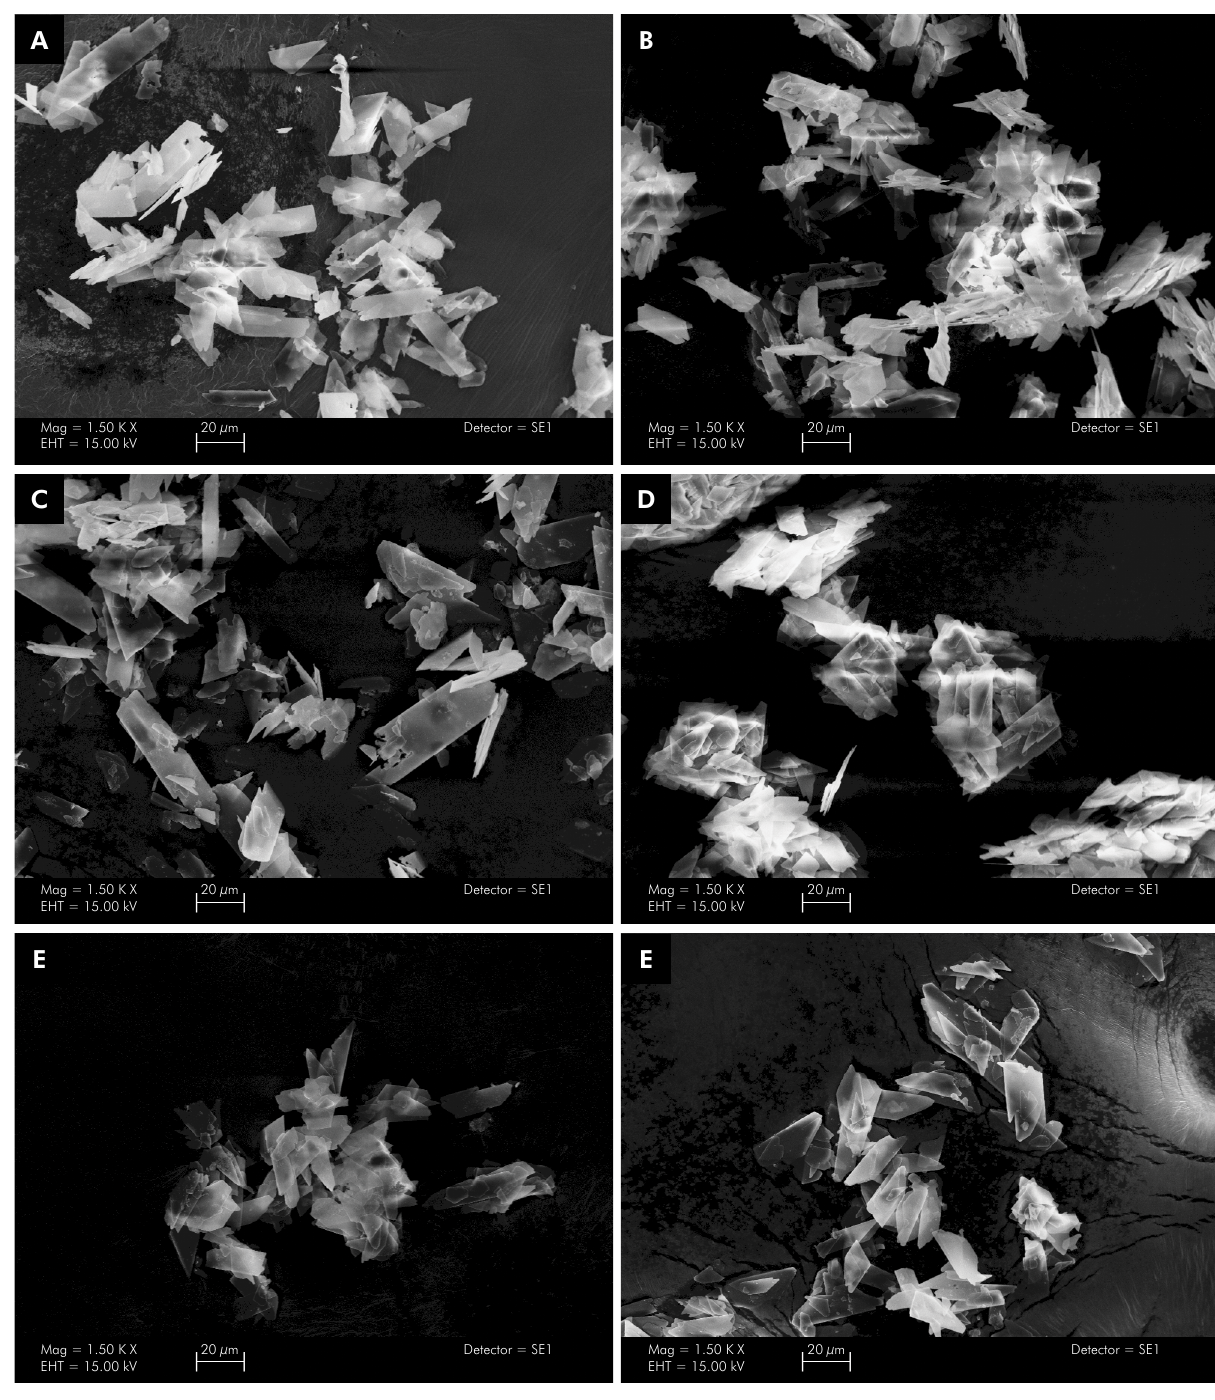
Figure. Scanning electron microscopic images of the groups of synthesized particles, with an increase of 1,500 times. A–C present particles synthesized with the ammonium phosphate solution as the receptor, functionalized during (AP_ab) or after synthesis (AP_ap) or without a functionalizing agent (AP_nf); and D–F illustrate the particles synthesized with the calcium nitrate solution as the receptor, functionalized during (CN_ab) or after synthesis (CN_ap) or without functionalizing